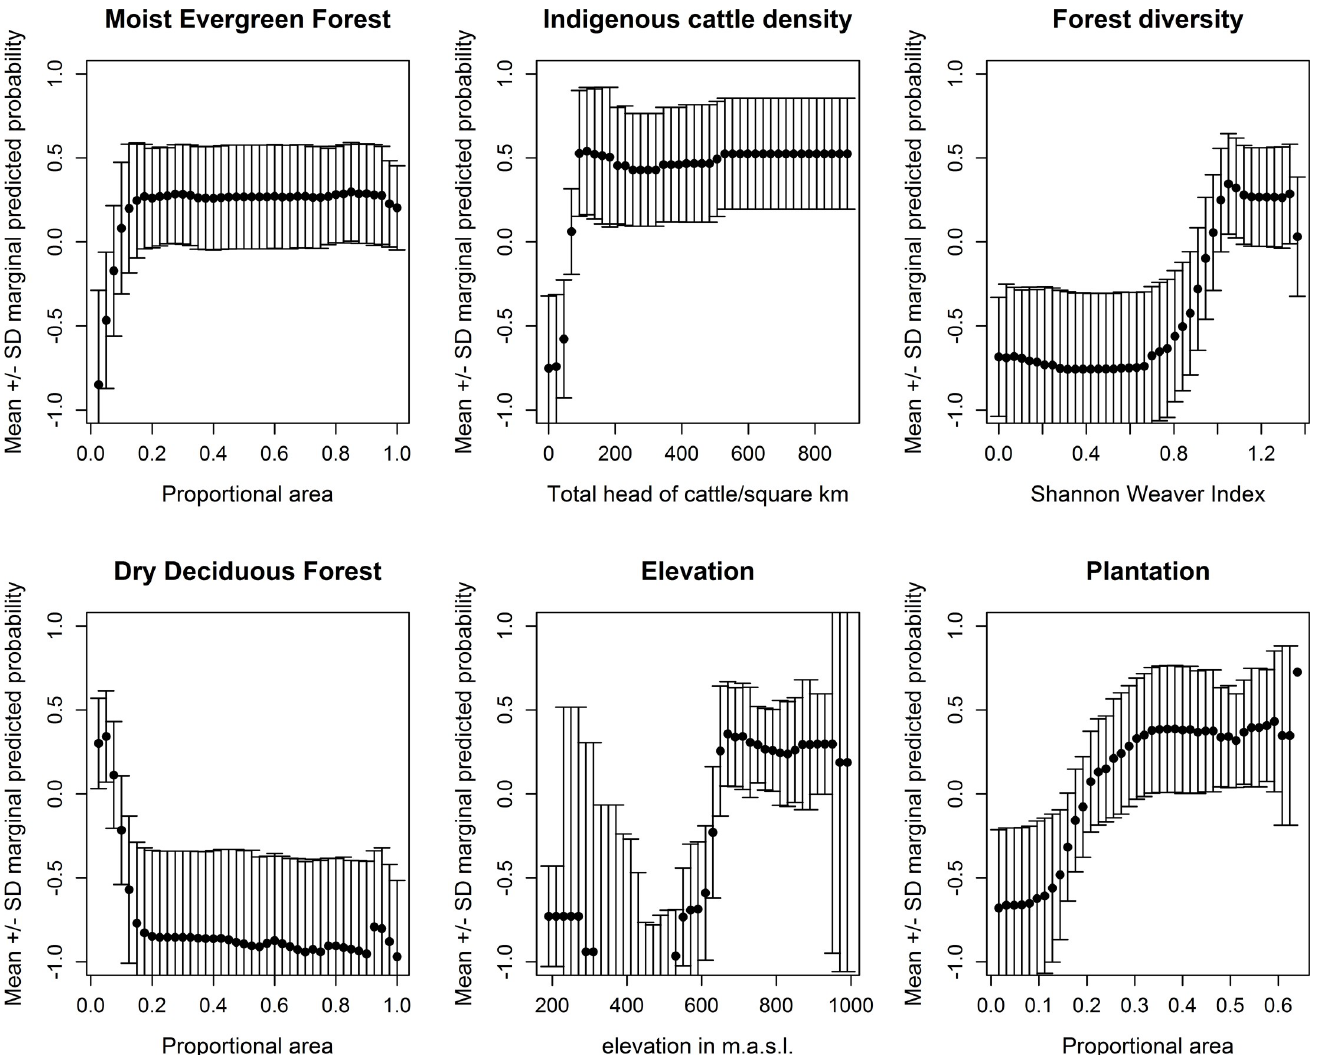
Fig 4. Marginal response plots for key predictors of presence of human cases of Kyasanur Forest Disease, from models at a 1 km resolution (without forest loss as a